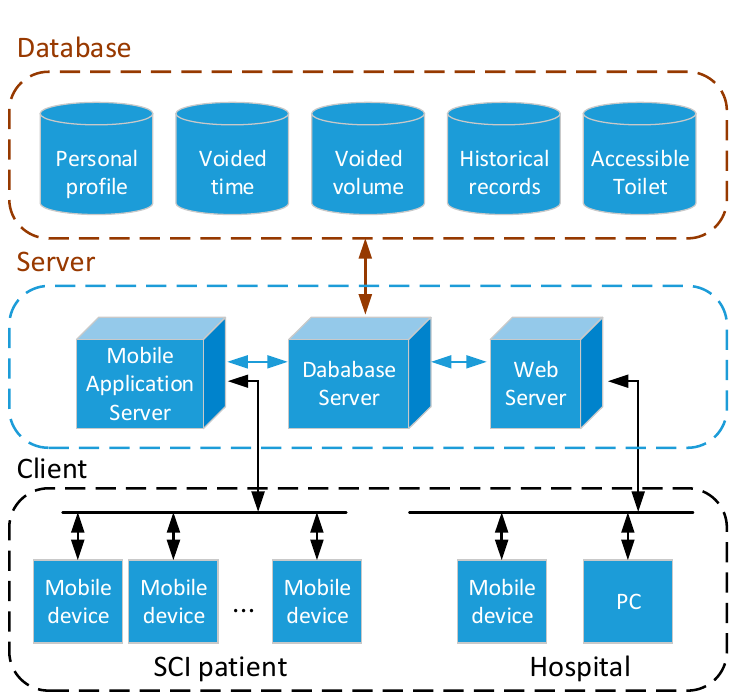
Figure 4. Relational database management system.